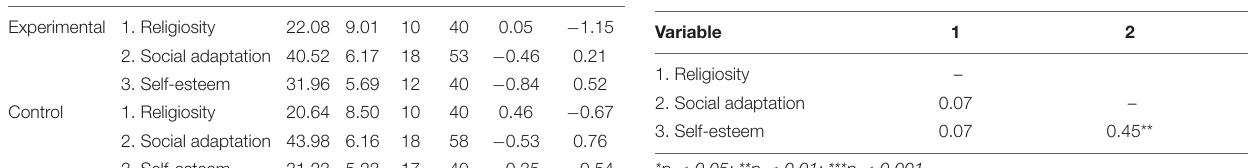
TABLE 2 | Correlations for study